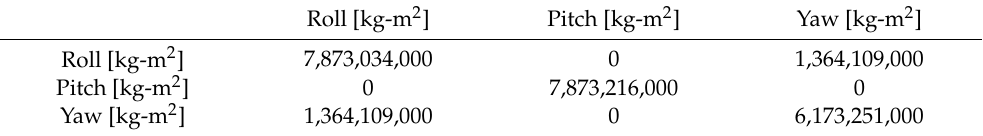
Table 7. 3CP inertia about objective’s center of mass.